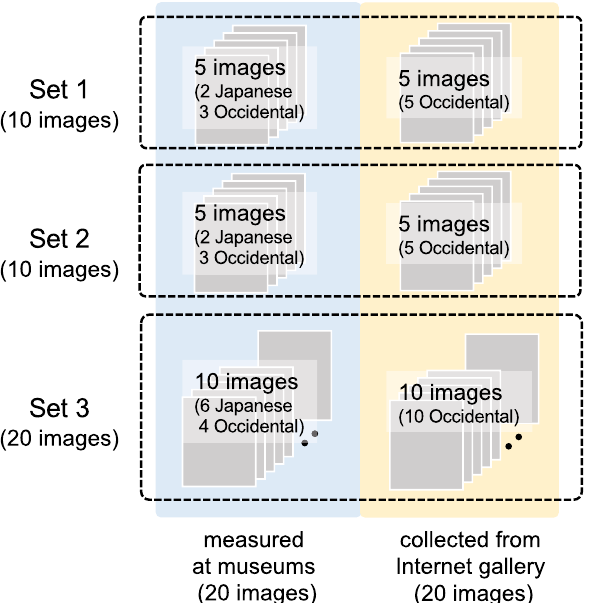
Figure 1. Paintings used in the experiments. Ten Japanese and ten Occidental paintings were digitized at museums or laboratories in Japan and Portugal using a hyperspectral imaging technique. In addition to these, 20 more paintings were added from art galleries on the Internet. The total of 40 images of paintings were divided into three sets, in which Sets 1 and 2 comprised ten images each, and Set 3 comprised 20 images. These image sets were used in different experimental conditions. Specific information on the paintings is given in Table